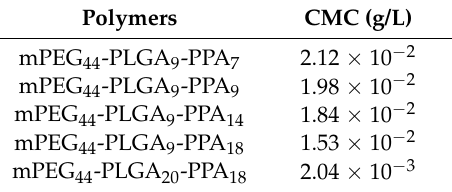
Table 2. Critical micelle concentration (CMC) values of mPEG-PLGA-PPA copolymers. Polymers